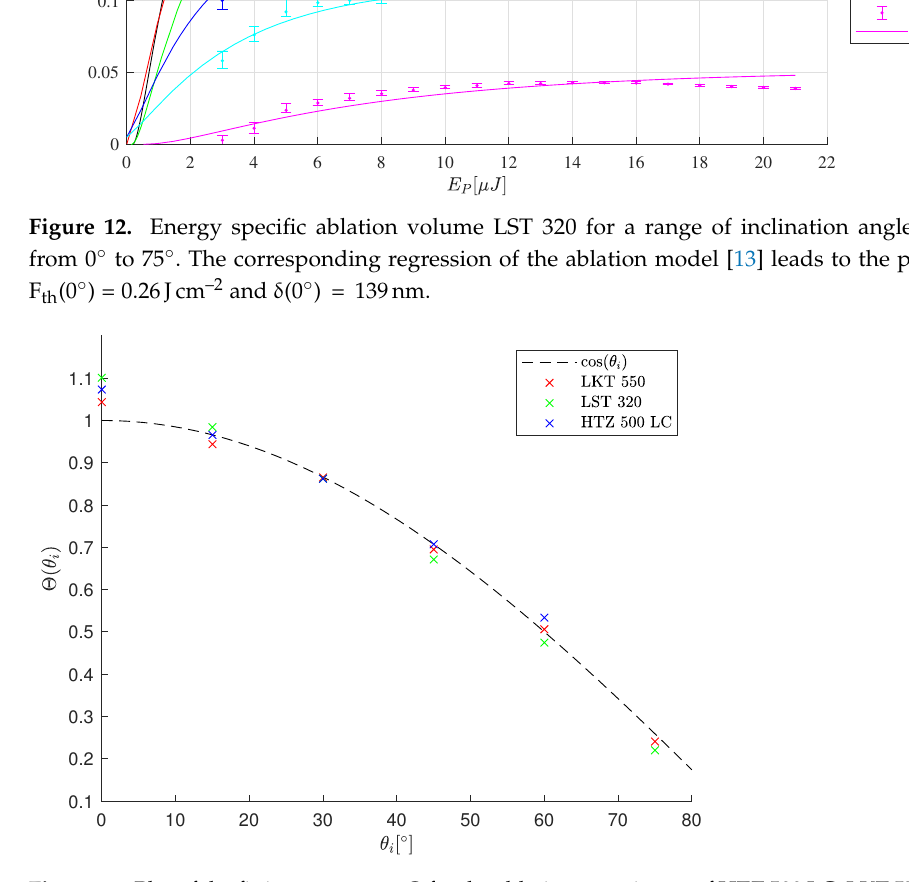
Figure 13. Plot of the fitting parameter Θ for the ablation experiment of HTZ 500 LC, LKT 550 and LST 320. The plot reveals that the relative absorptance is nearly equal to 1. Deviations can be explained by plasma and particle shielding at a low angle of incidence. The relative absorptance A is normalized by the absolute absorptance of all tested ceramics at